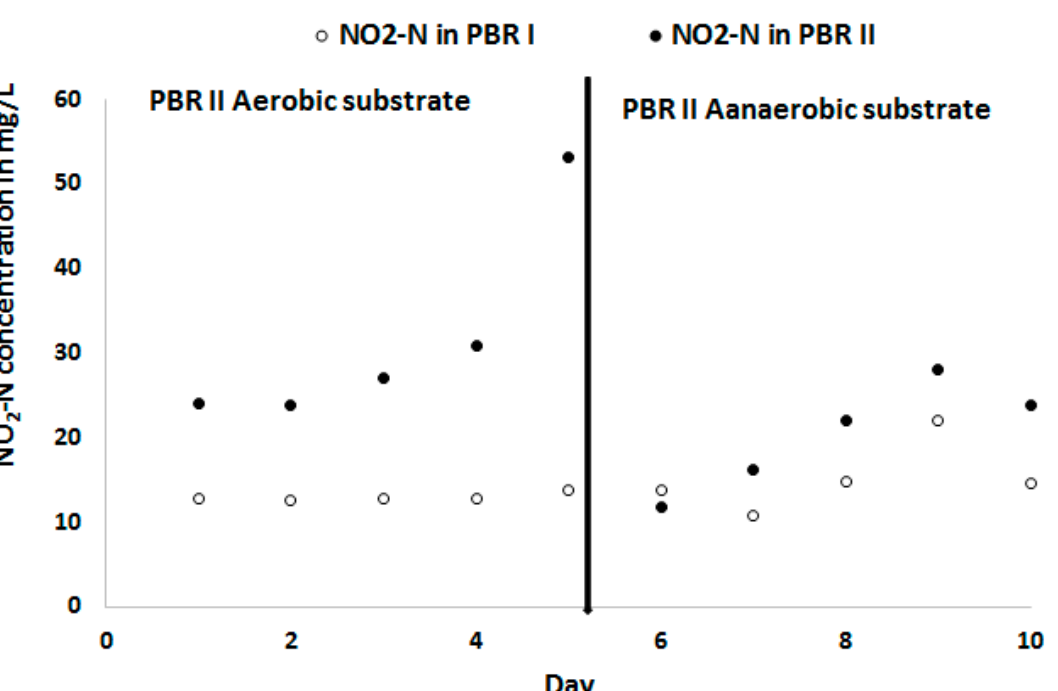
Figure 8. Nitrite concentrations in the anaerobic substrate PBR I (o), and aerobic and anaerobic substrate in PBR II ( ● ).